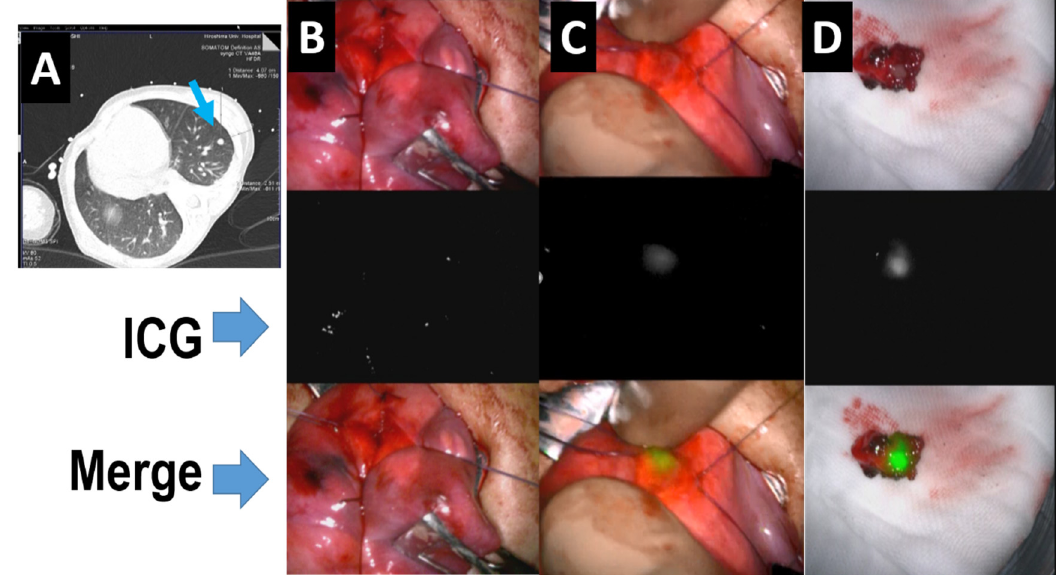
Figure 4. ICG detection of a deep lung metastasis by ICG fluorescence. ( A ) CT scan shows the existence of a lung metastasis. ( B ) Video screenshot of ICG navigation surgery. ( C ) ICG positive nodules. ( D ) The pathological finding of a small ICG-positive nodule.